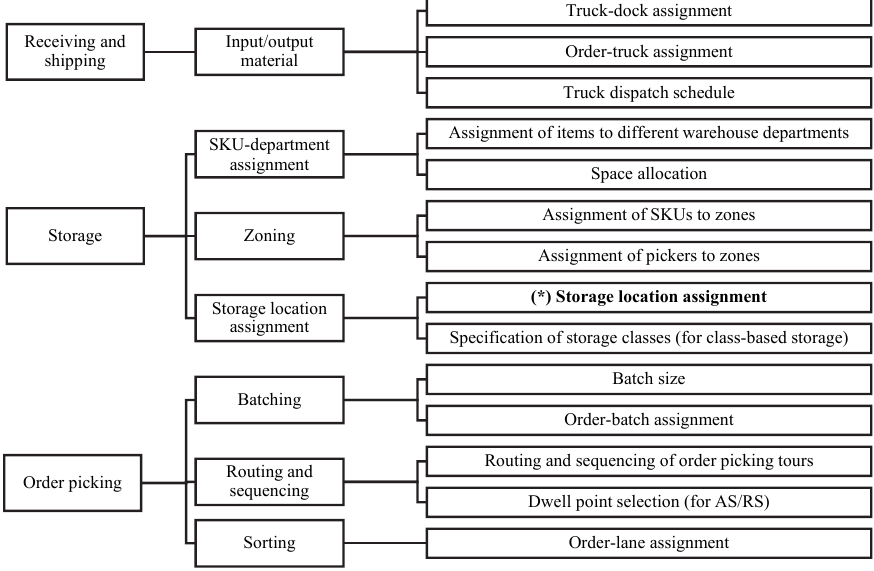
Fig. 1. Operational decisions in storage management. Source: Adapted from (Gu et al.,